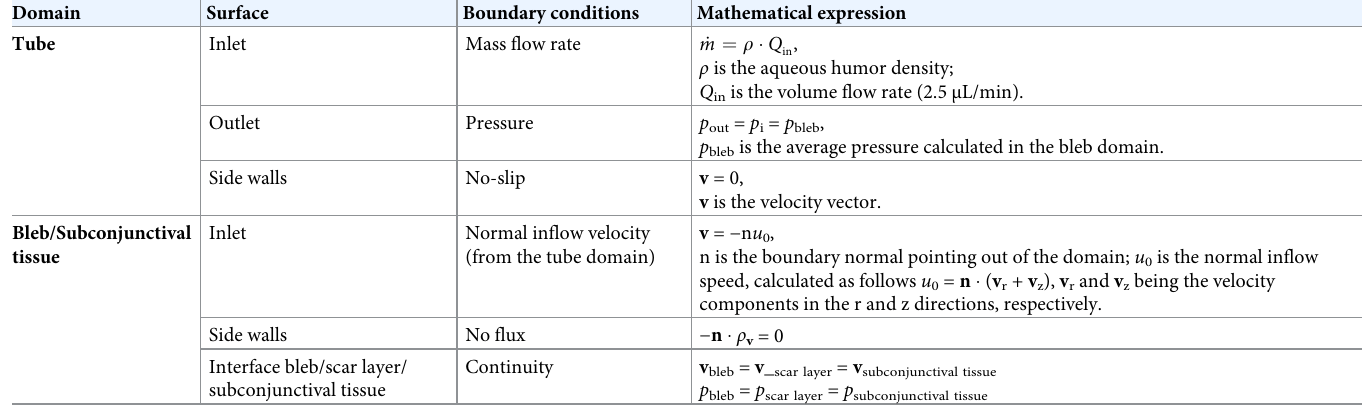
Table 2. Boundary conditions used in the simulations for the shunt and bleb/scar layer/subconjunctival tissue domains.